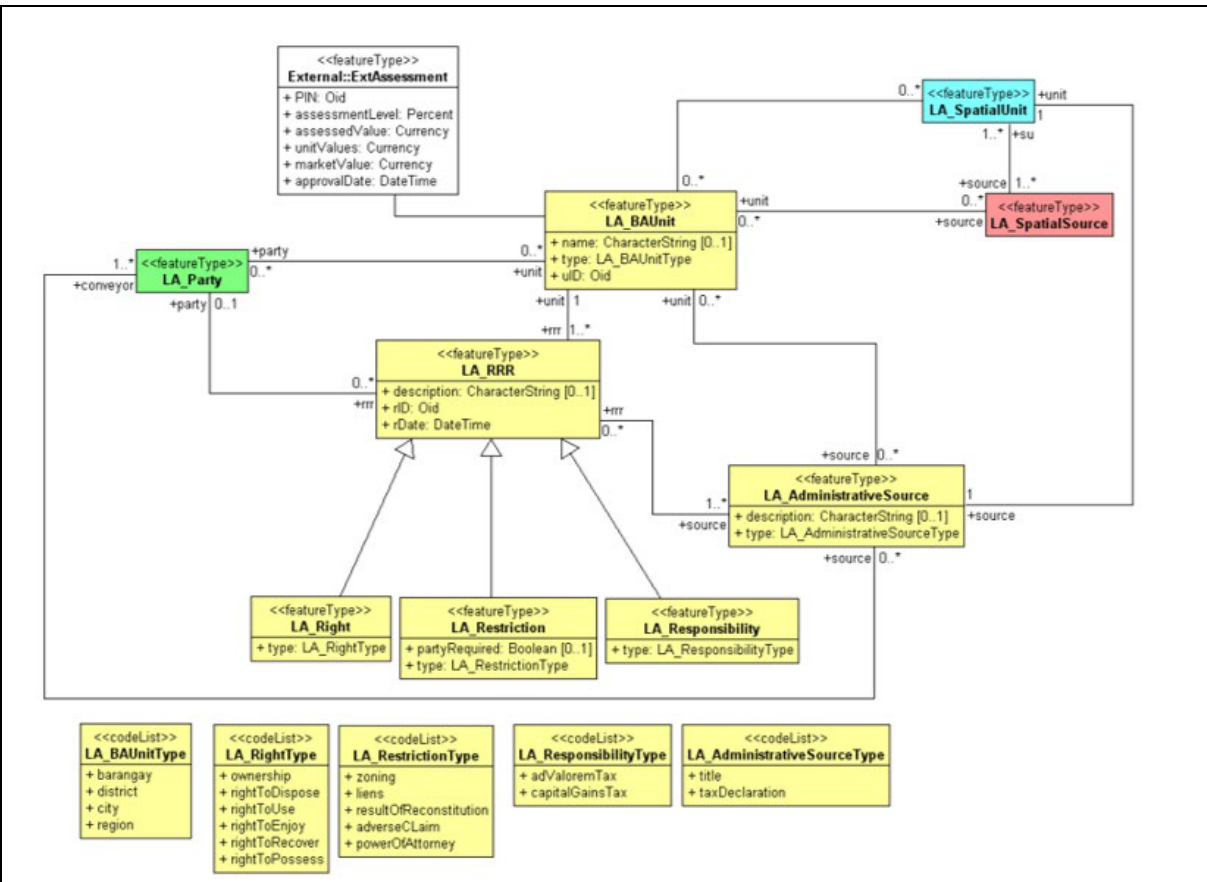
Figure 5 . Localized classes of the Administrative